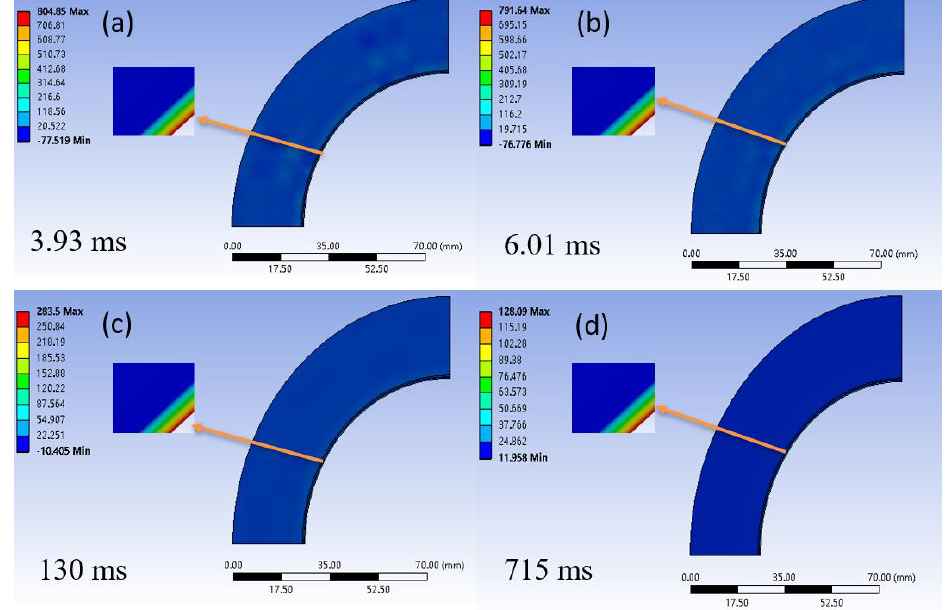
Figure 6. Cloud diagrams of the temperature of the A section (CrN/Cr composite coating). ( a ) 2.25 ms, ( b ) 6.01 ms, ( c ) 130 ms and ( d ) 715 ms after the gun is fired.